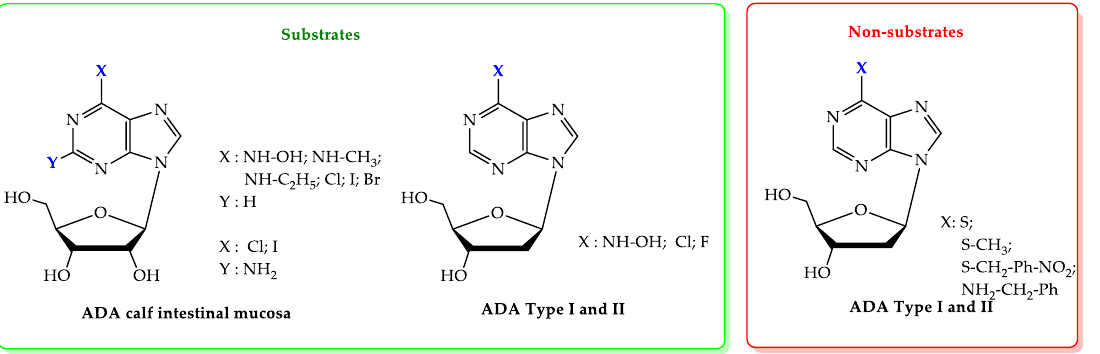
Figure 2. ADA substrates (green frame) and non-substrates (red frame). Data from ref. [20,21].